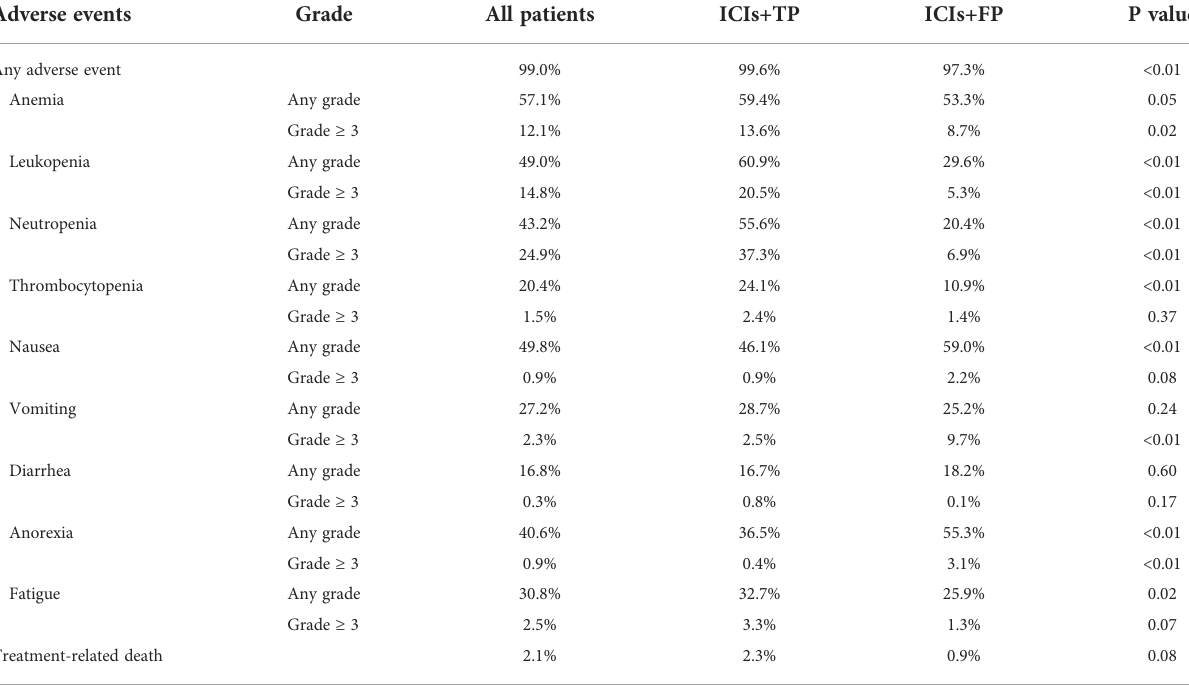
TABLE 3 Pooled incidence rates of adverse events in ESCC patients who received chemo-immunotherapy. Adverse